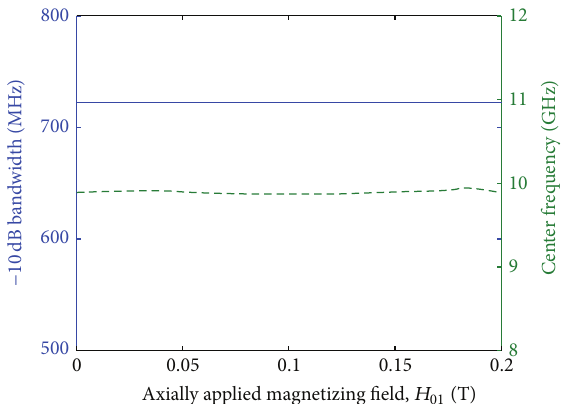
Figure 5: Simulated impedance bandwidth ( − 10dB bandwidth) and center frequency for the ferrite loaded MPA for varying biasing 𝐻 01